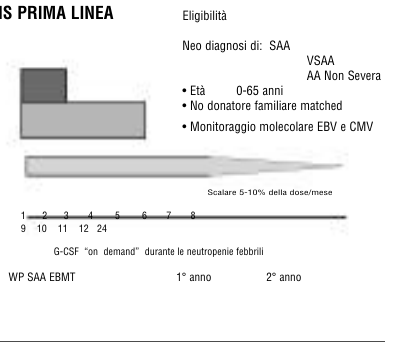
Figura 3. Sopravivenza a 10 anni dopo tera pia IS in adulti vs.